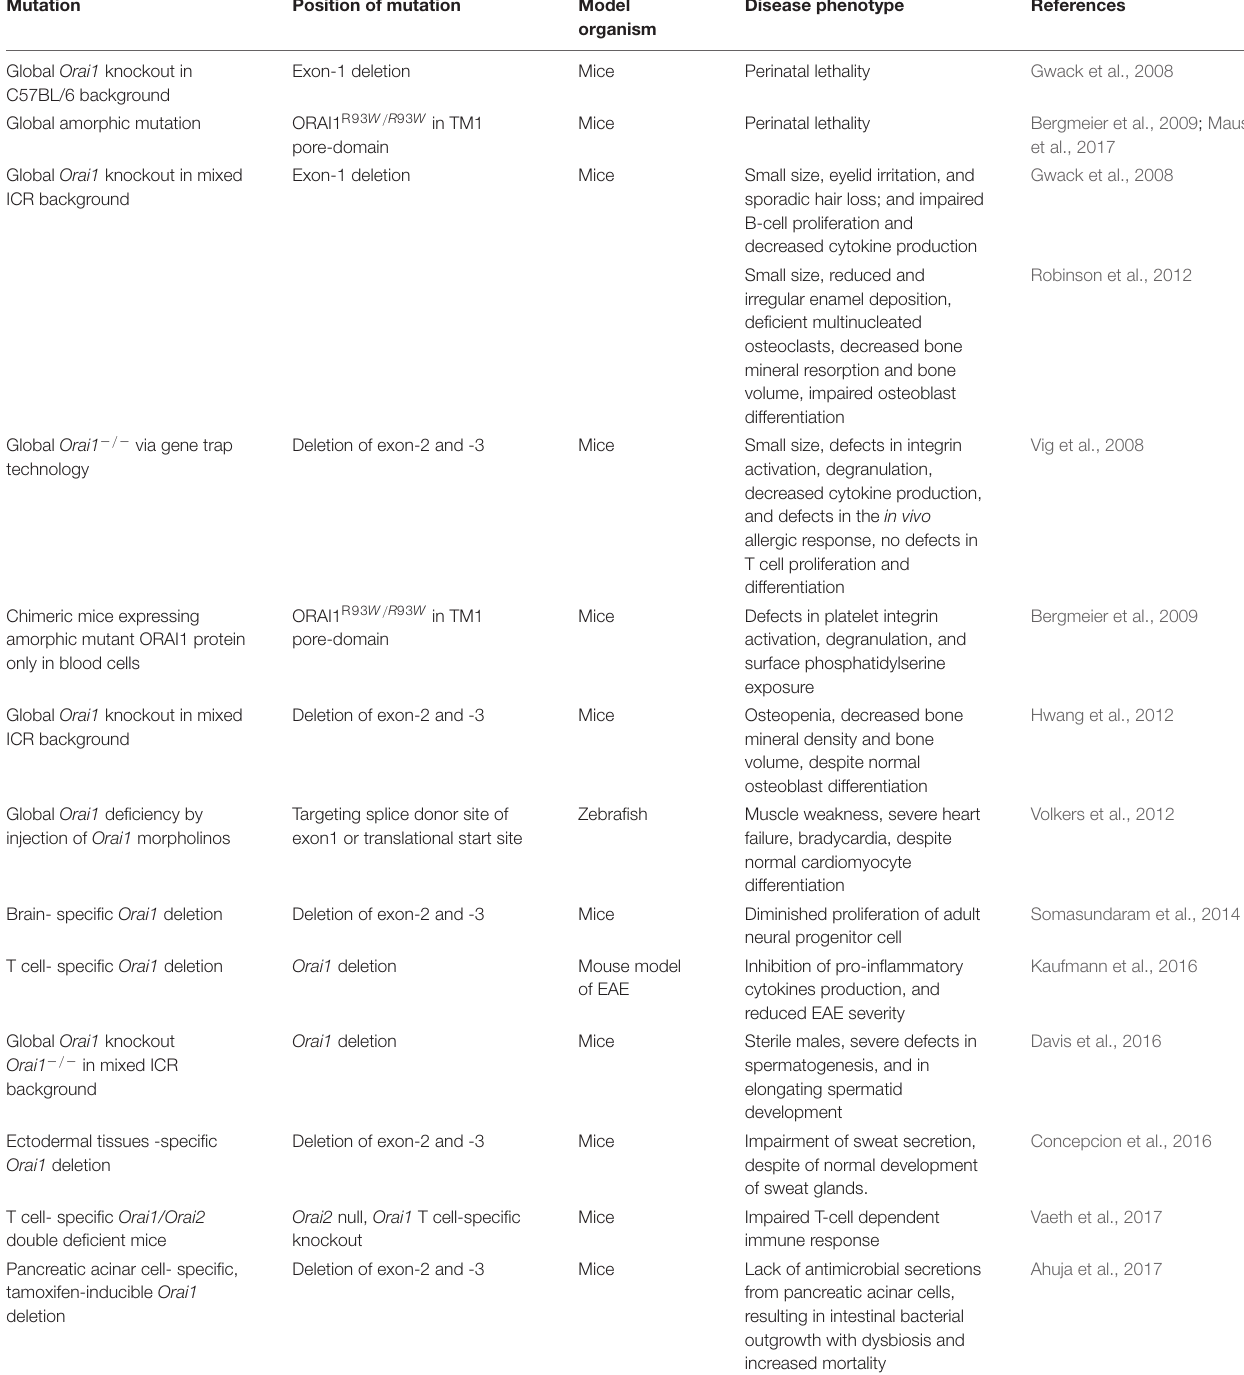
TABLE 2 | ORAI1 mutations and resulting phenotype in animal